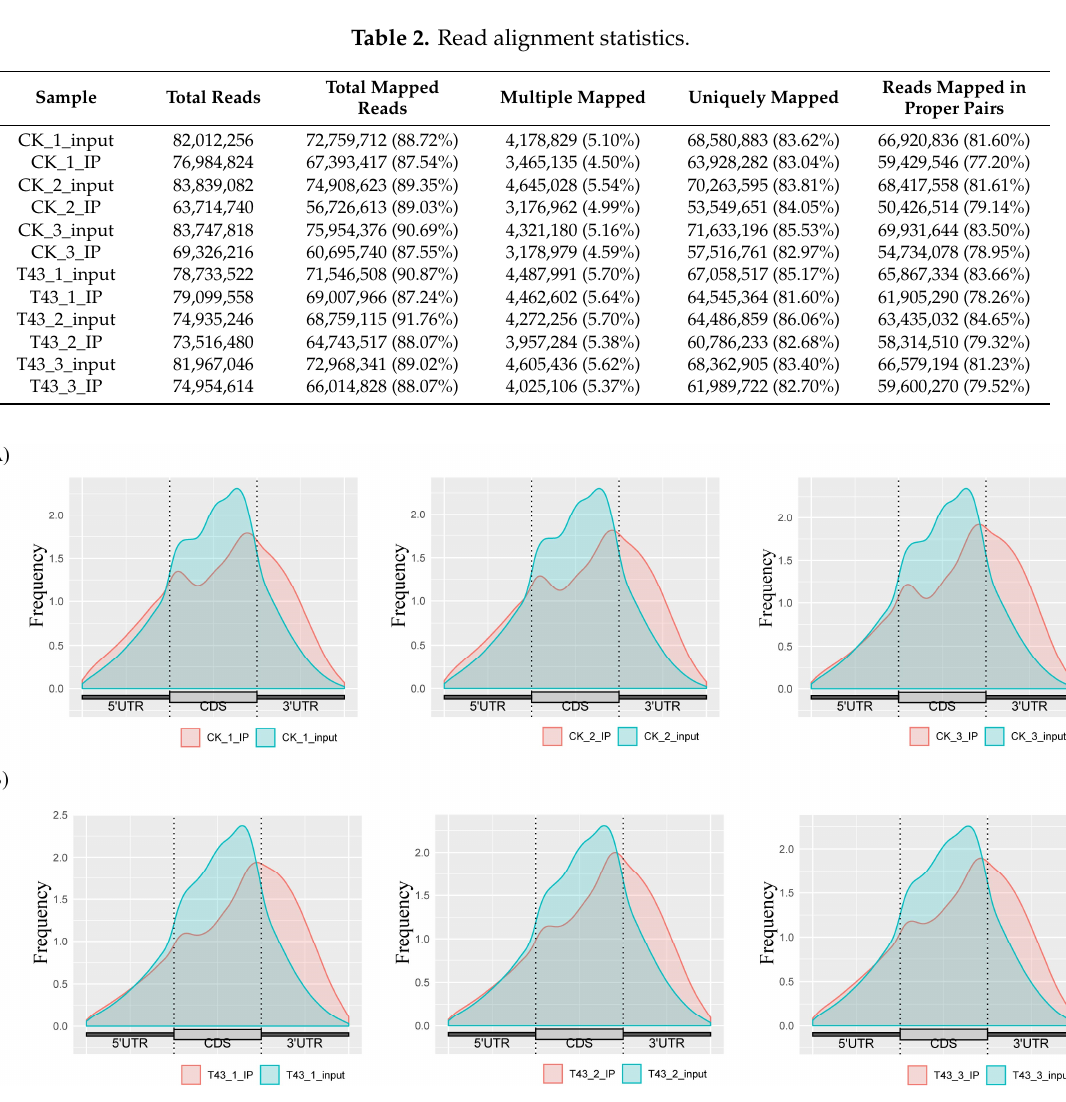
Figure 1. Distribution of m 6 A methylome along Pak-choi transcripts. Each transcript is divided into three parts: 5 (cid:48) UTR, CDS, and 3 (cid:48) UTR. ( A ) Normal (CK) group; ( B ) heat stress (T43) group. The m 6 A peaks (actually identified as m 6 A modification sites) were identified based on a comparison of read distribution between the input and IP samples using the MeTDi ff package. In the T43 and CK groups, 15,919 and 15,436 m 6 A peaks were identified, respectively (Figure 2A). The